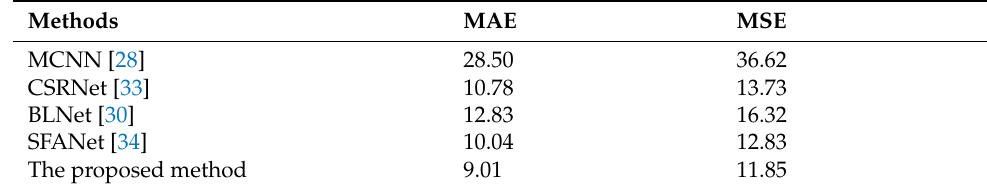
Table 3. The influence of different Gaussian kernel sizes on the model accuracy.